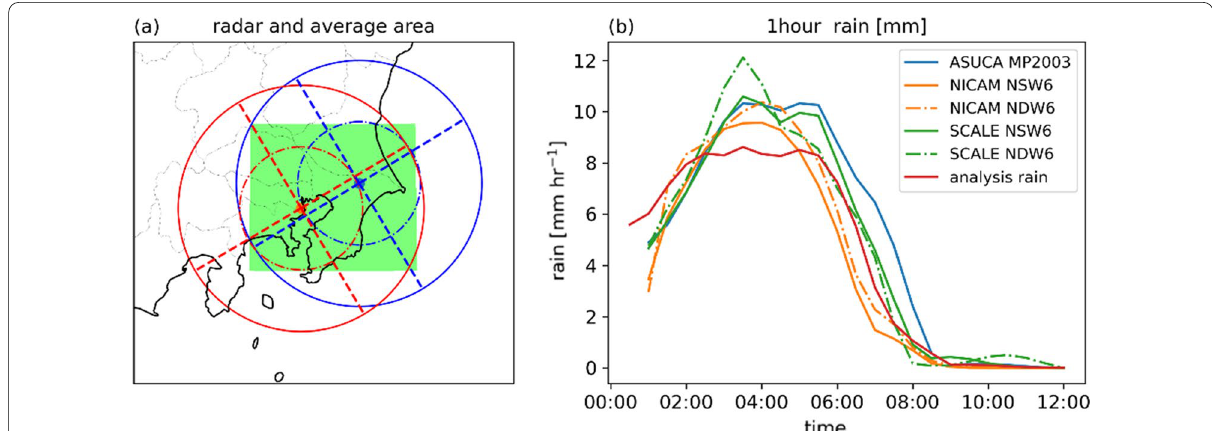
Fig. 5 a Distance circles with a radius of 60 km (dashed circle) and 120 km (solid circle) from the Haneda (red) and Narita (blue) radars. The dotted lines indicate the RHI (Range–Height Indicator) observation lines. Green shading shows the area used to compare rainfall and mass concentrations.